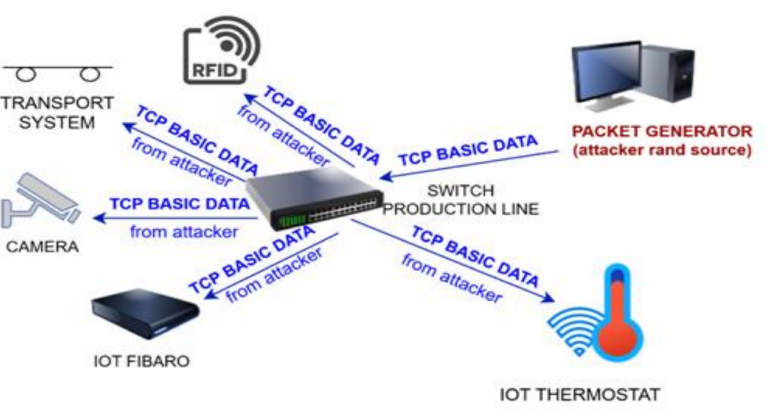
Figure 8. A visual illustration of the scenario 4 attack.